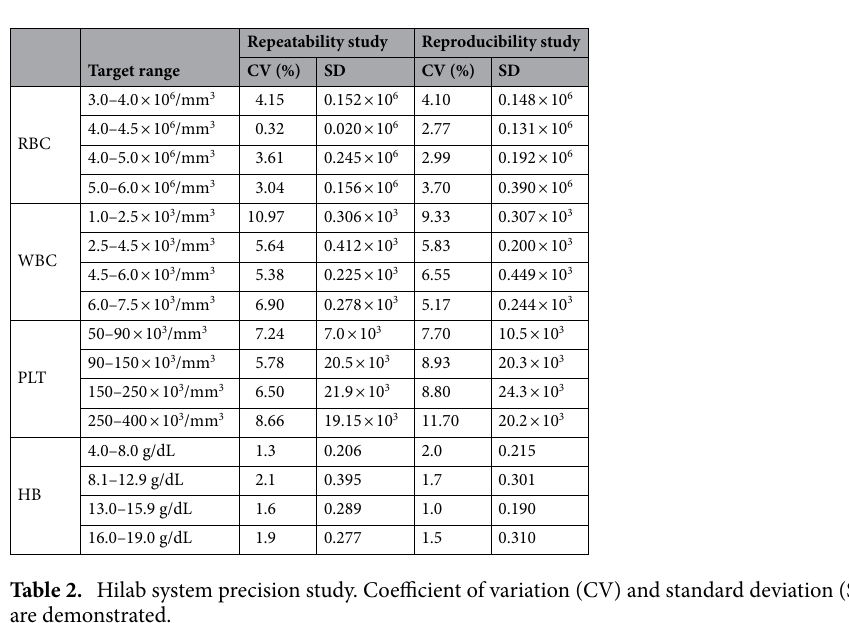
Table 2. Hilab system precision study. Coefficient of variation (CV) and standard deviation (SD) of each range are demonstrated.